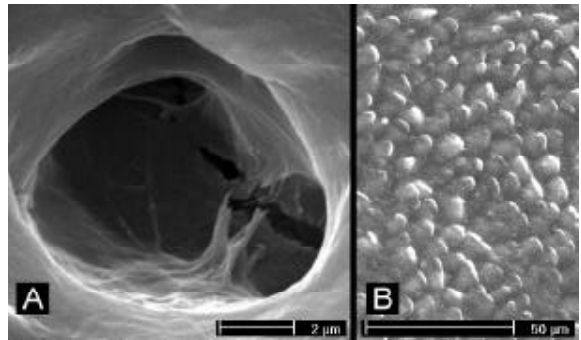
FIGURA 8- grupo 6 – dentes instrumentados e condicionados com EDTA gel: A – túbulo dentinário totalmente desobstruído com fibras colágenas (aumento 8000X); B – smear layer removido e fibras colágenas